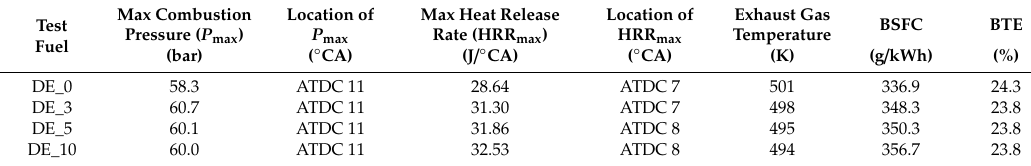
Table 4. Combustion characteristics under test conditions.